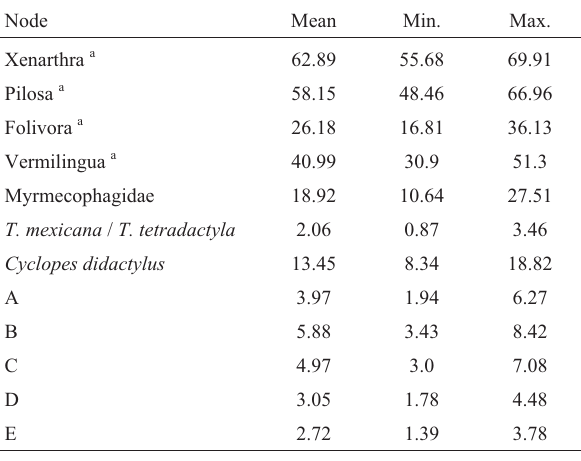
Table 1 - Divergence time estimates for Cyclopes didactylus and other xenarthran nodes inferred in this study. Node ages were obtained using the reversible-jump based substitution model with gamma rate heterogeneity and invariant sites and a relaxed clock model. Mean posterior estimates and 95% HPD intervals are expressed in million years ago. Divergence dates less than 1 mya are not shown. Letters A - E refer to nodes in Figure